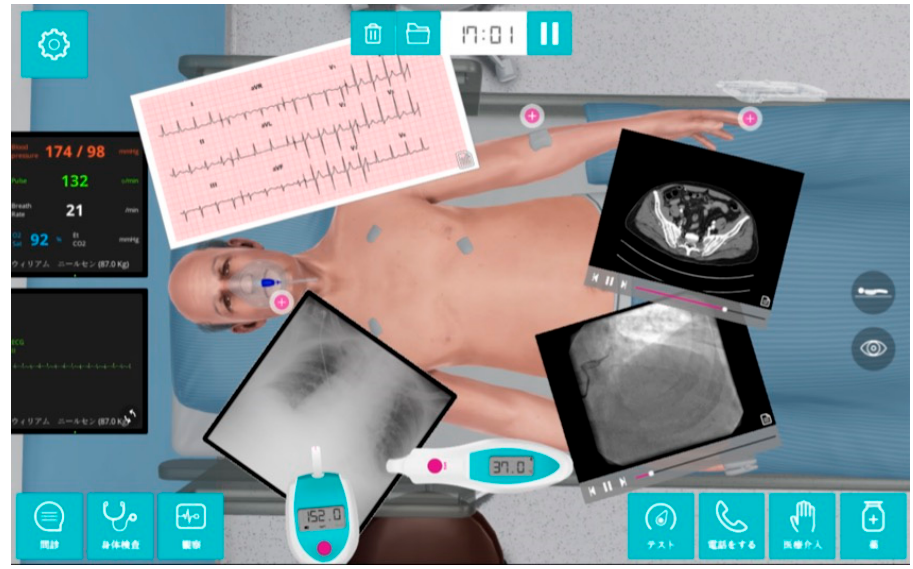
Figure 1. The virtual reality simulation software ( ® Body Interact, Coimbra, Portugal).